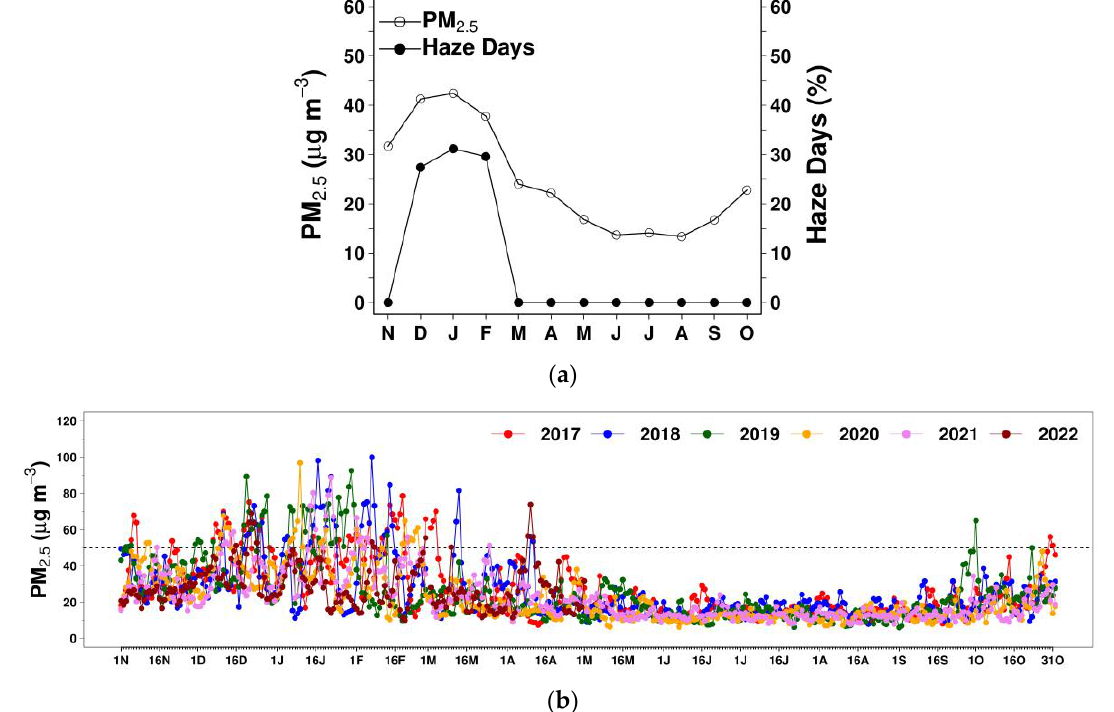
Figure 2. ( a ) Monthly variation for PM 2.5 and haze days over selected PCD stations over the season years 2017 – 2022; ( b ) daily PM 2.5 for Greater Bangkok. The x-axis labels (N, D, J, F, M, ..., S and O) denote the months of the year from November to October.